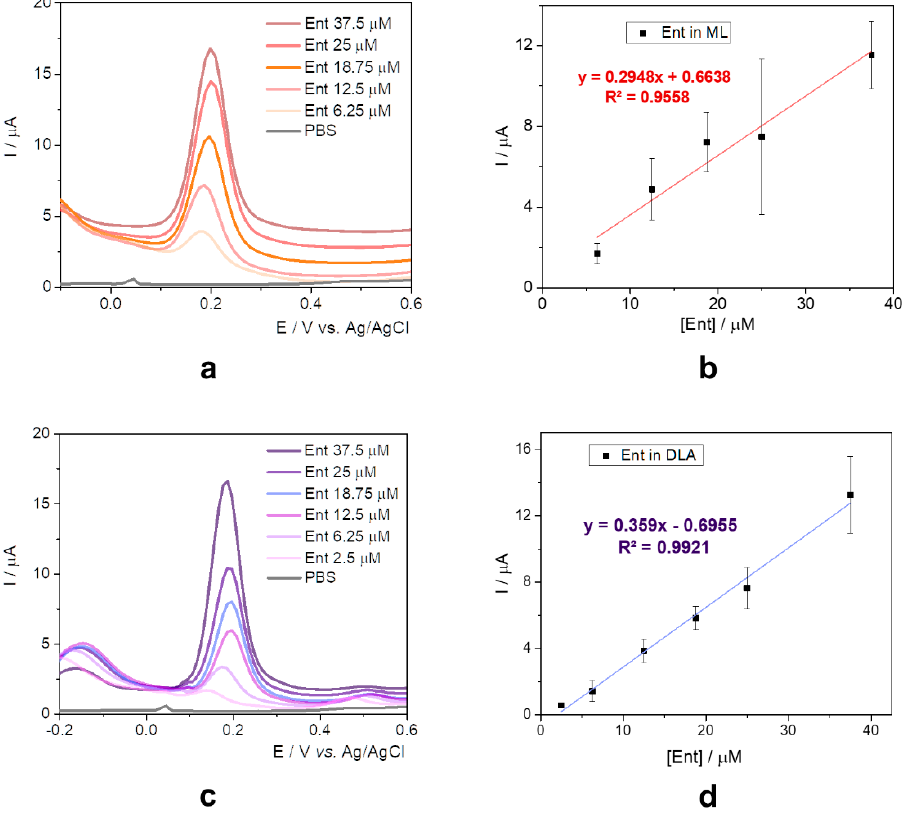
Figure 4. ( a ) DPVs for 6.25–37.5 µ M Ent in ML diluted 1:50 with 20 mM PBS pH 7.4 at graphite SPE; ( b ) calibration curve for Ent in ML; ( c ) DPVs for 2.5–37.5 µ M Ent in DLA suspended in 20 mM PBS pH 7.4 (1 mg/0.05 mL PBS) at graphite SPE; ( d ) calibration curve for Ent in DLA.